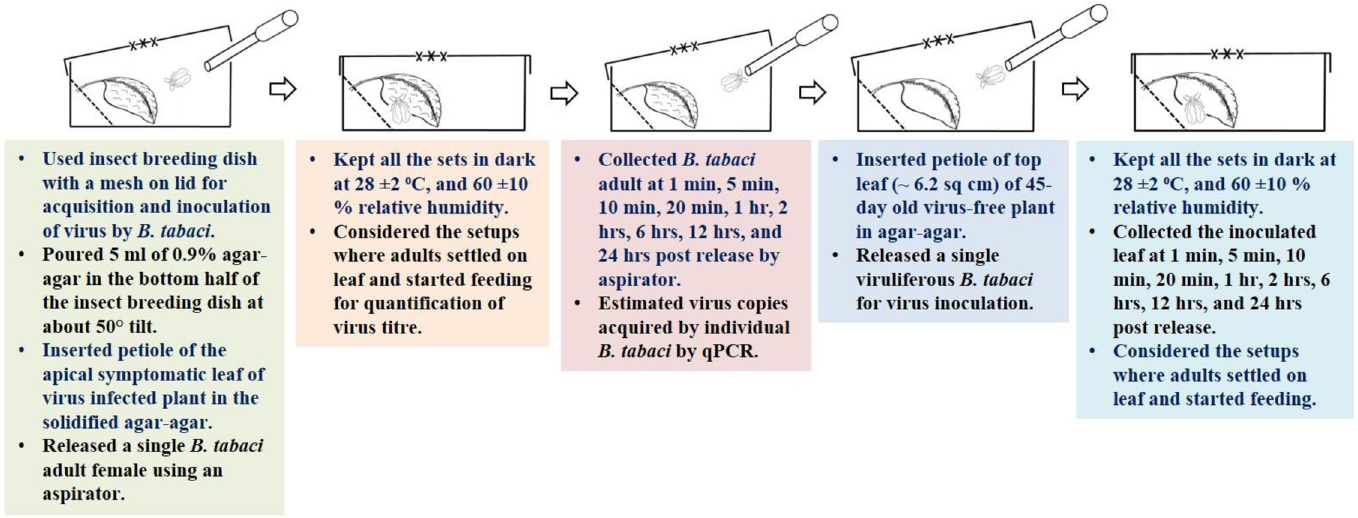
Fig 1. Ingestion and egestion of ToLCNDV and ChiLCV by single B . tabaci using detached leaf assay.